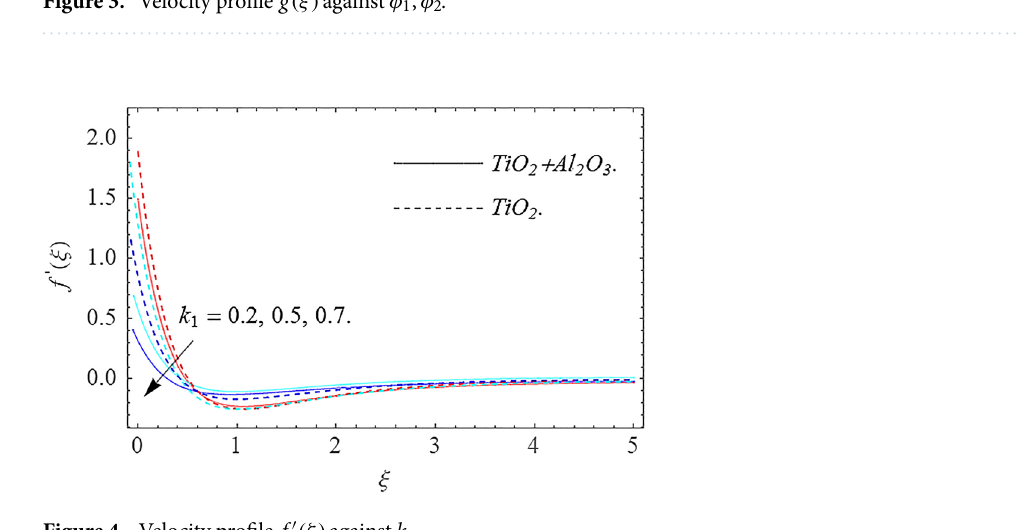
Figure 4. Velocity profile f ′ (ξ) against k 1